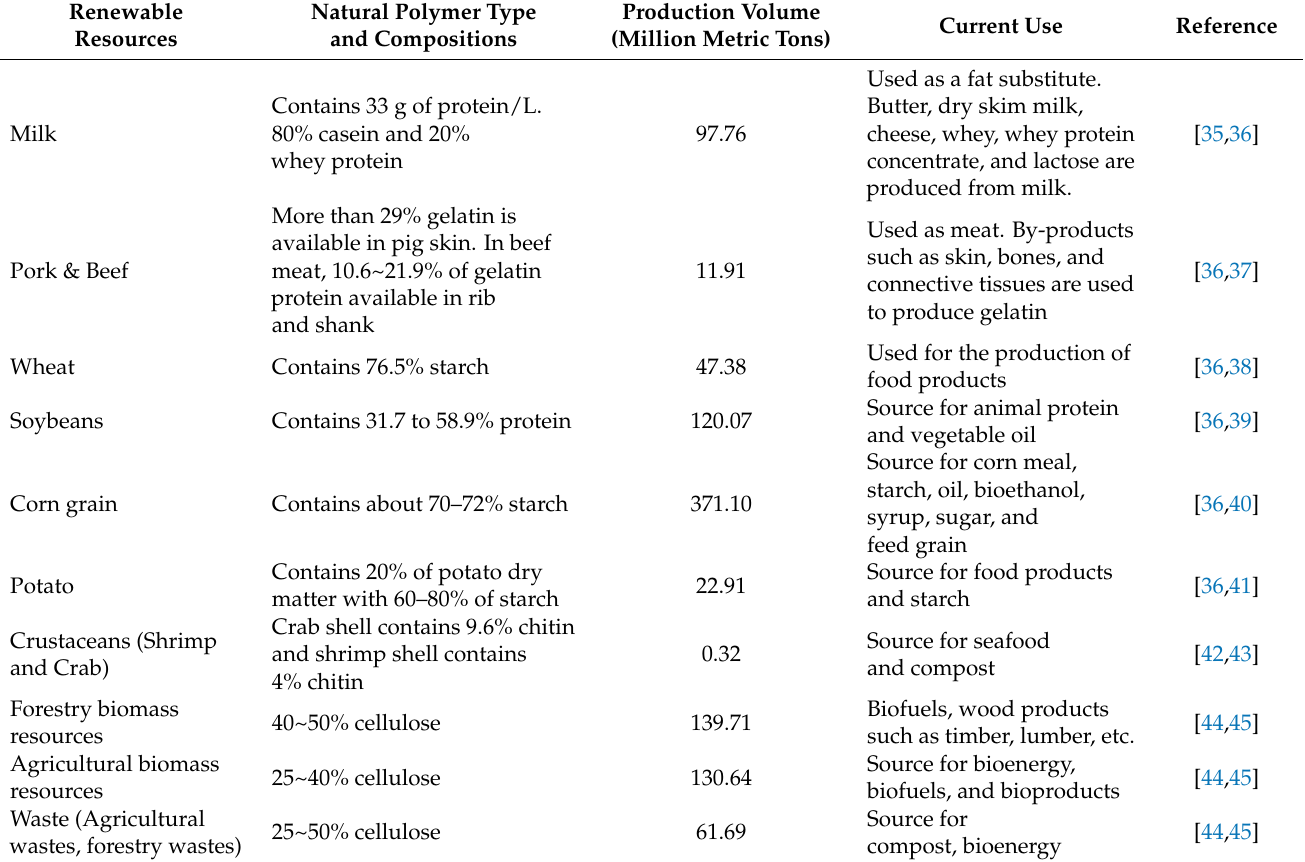
Table 1. Renewable resources and their production volume in the U.S.A. during the year